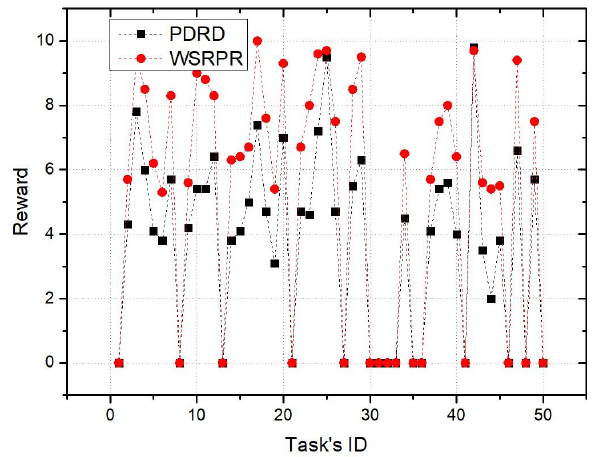
Figure 7. Comparison of reward.